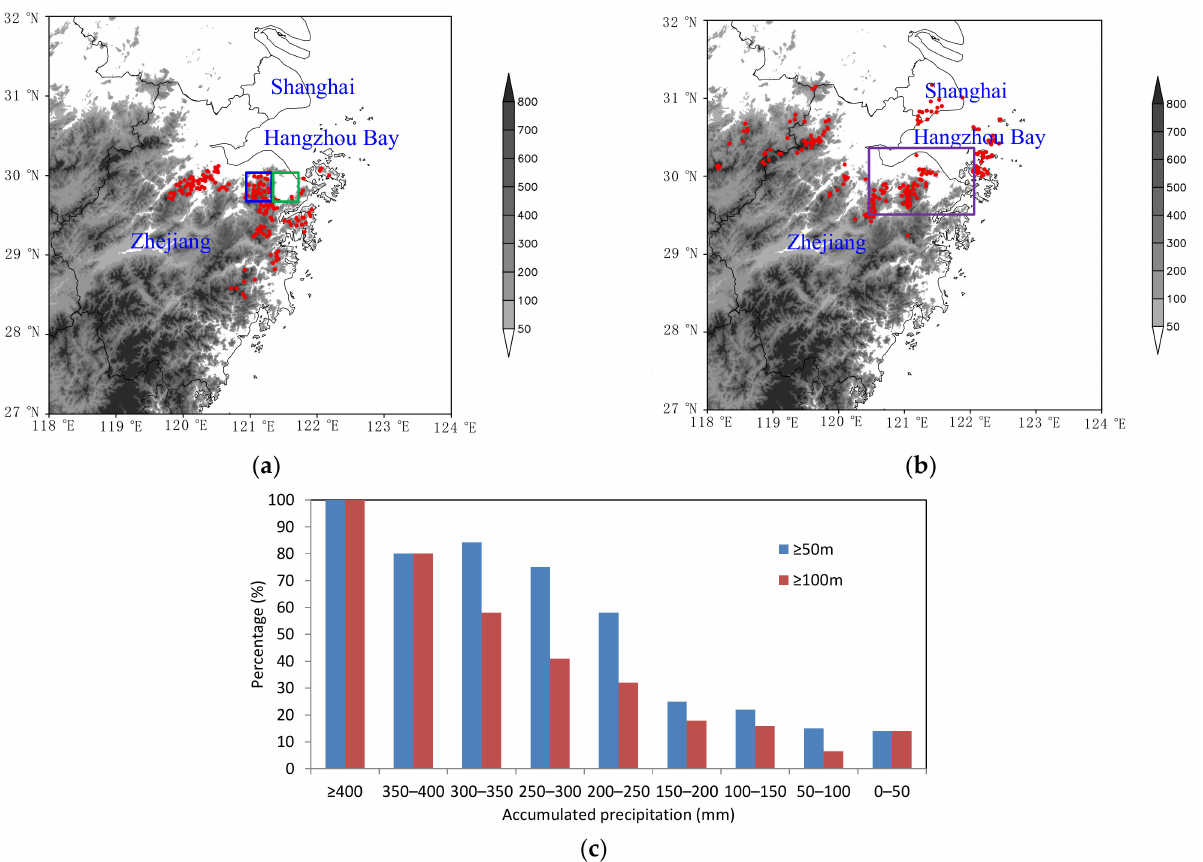
Figure 13. ( a , b ) Distribution of stations with precipitation ≥ 250 mm (red dots) and terrain heights (shaded, unit: m), ( a ) before In-Fa’s landfall at 0800 BT on July 22 July, 2021, to 0800 BT on 25 July 2021; ( b ) during In-Fa’s landfall at 0800 BT on 25 July 2021, to 0800 BT on 27 July 2021; ( c ) percentage of stations with altitude greater than 50 m and 100 m, respectively, for different value of accumulated precipitation in northern Zhejiang shown by the purple frame in ( b ). The blue and green frames in ( a ) indicate Siming Mountain and the peripheral plains areas,